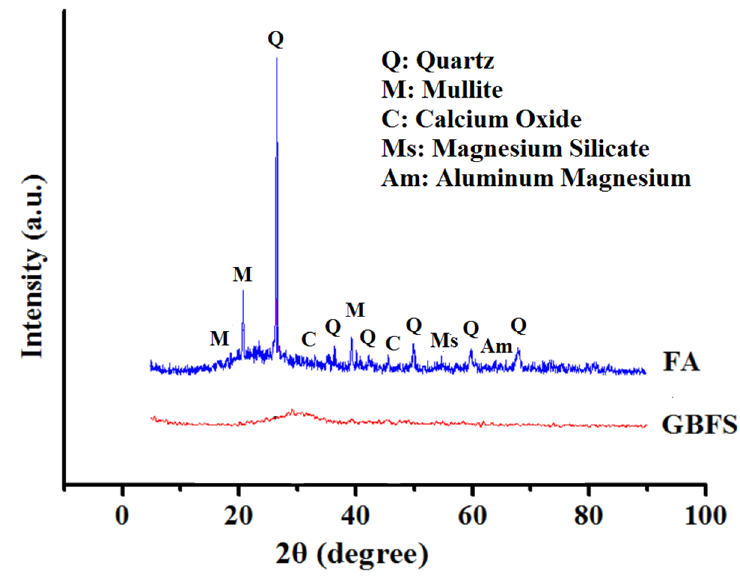
Figure 1. XRD di ff ractograms of fly ash (FA) and slag (GBFS). Figure 1. XRD diffractograms of fly ash (FA) and slag (GBFS).